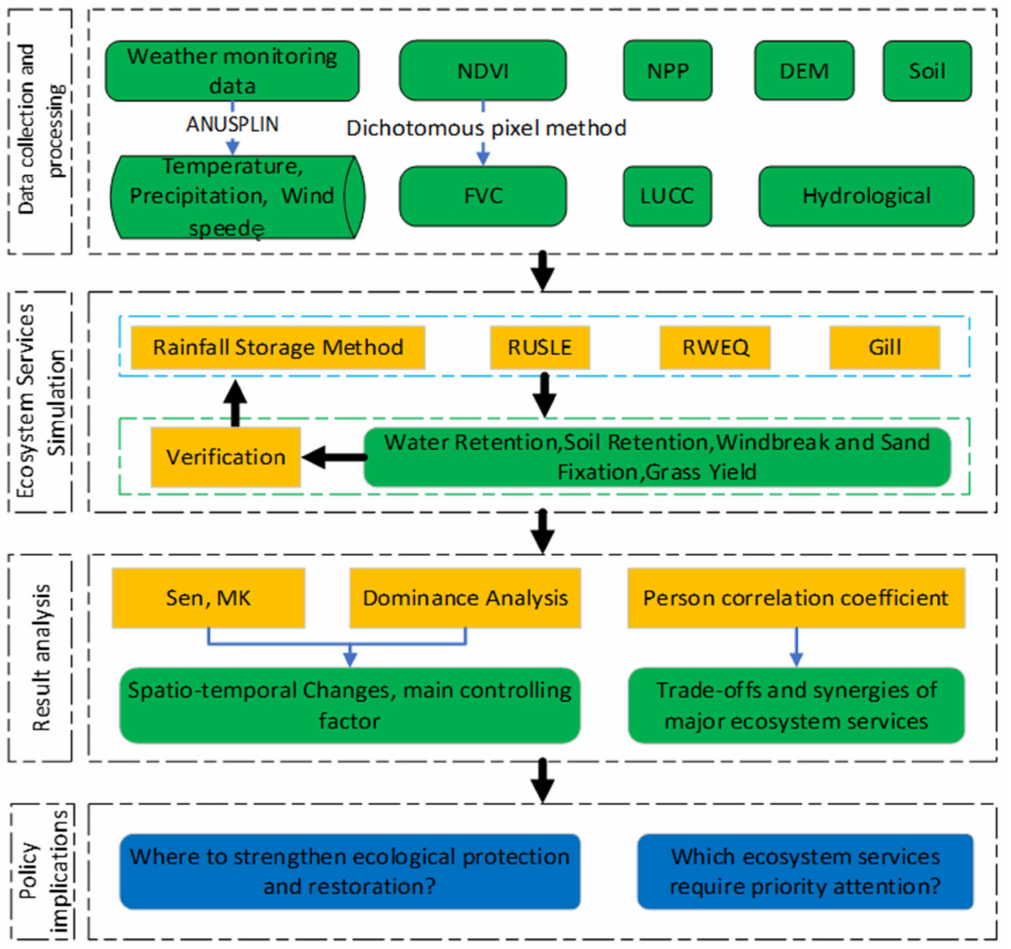
Figure 2. Technology roadmap of this